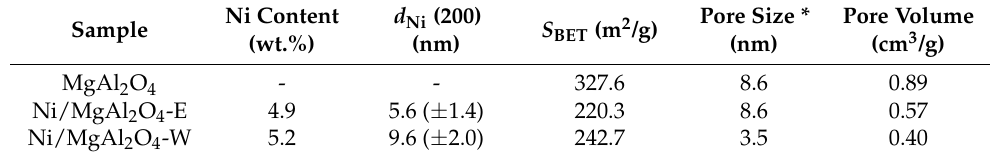
Table 1. Physicochemical characteristics for the Ni/MgAl 2 O 4 -W and Ni/MgAl 2 O 4 -E samples.